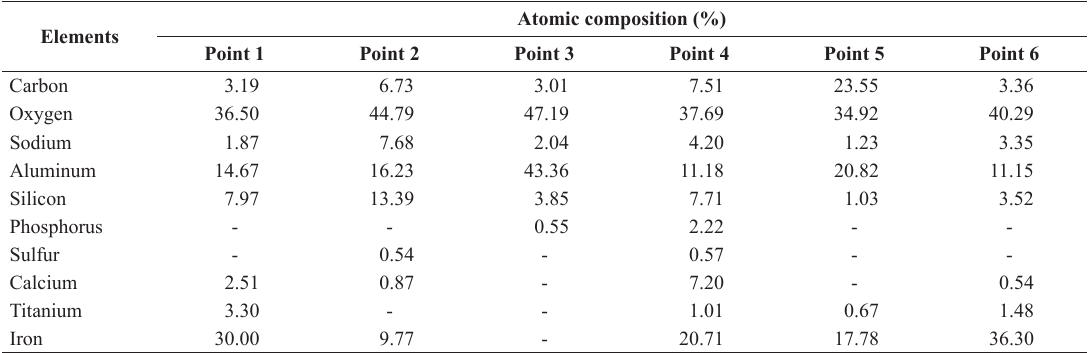
Table 1. Dried red mud atomic composition as determined by EDS on the points indicated in Figure 2